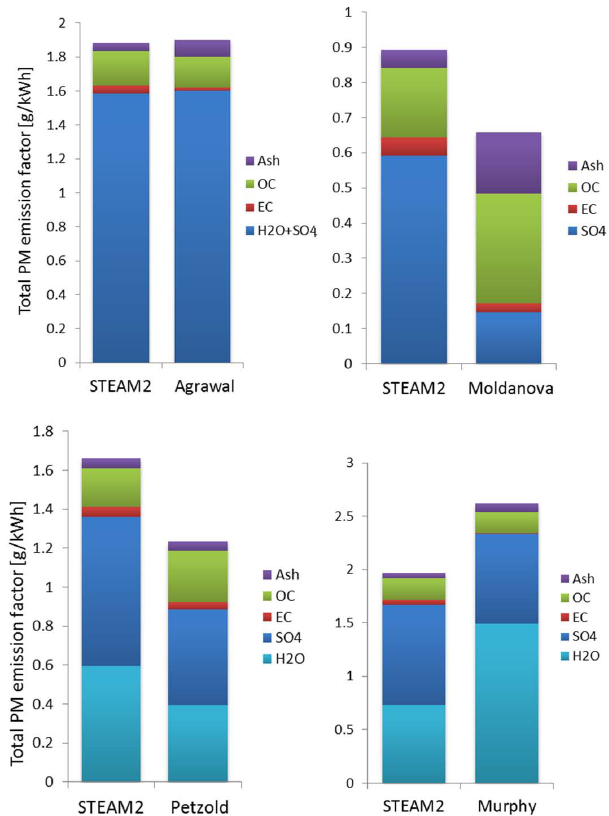
Fig. 11. (a)–(d) : comparison of the predicted and measured emis- sion factors for the chemical constituents of PM. The measured data has been extracted from Agrawal et al. (2008a), Moldanova et al. (2009), Petzold et al. (2008) and Murphy et al. (2009).